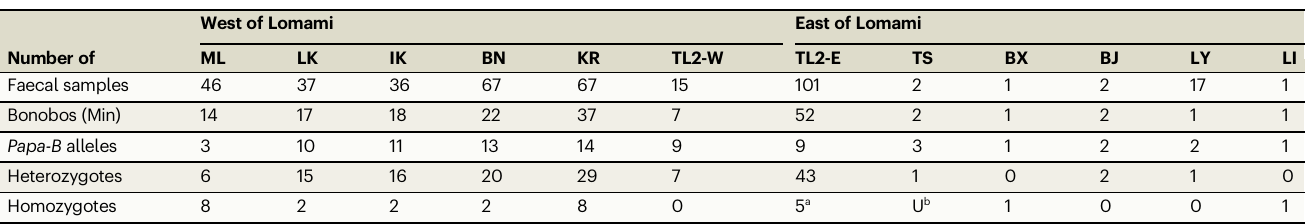
Table 1 | Number Papa-B homozygotes and heterozygotes per study site West of